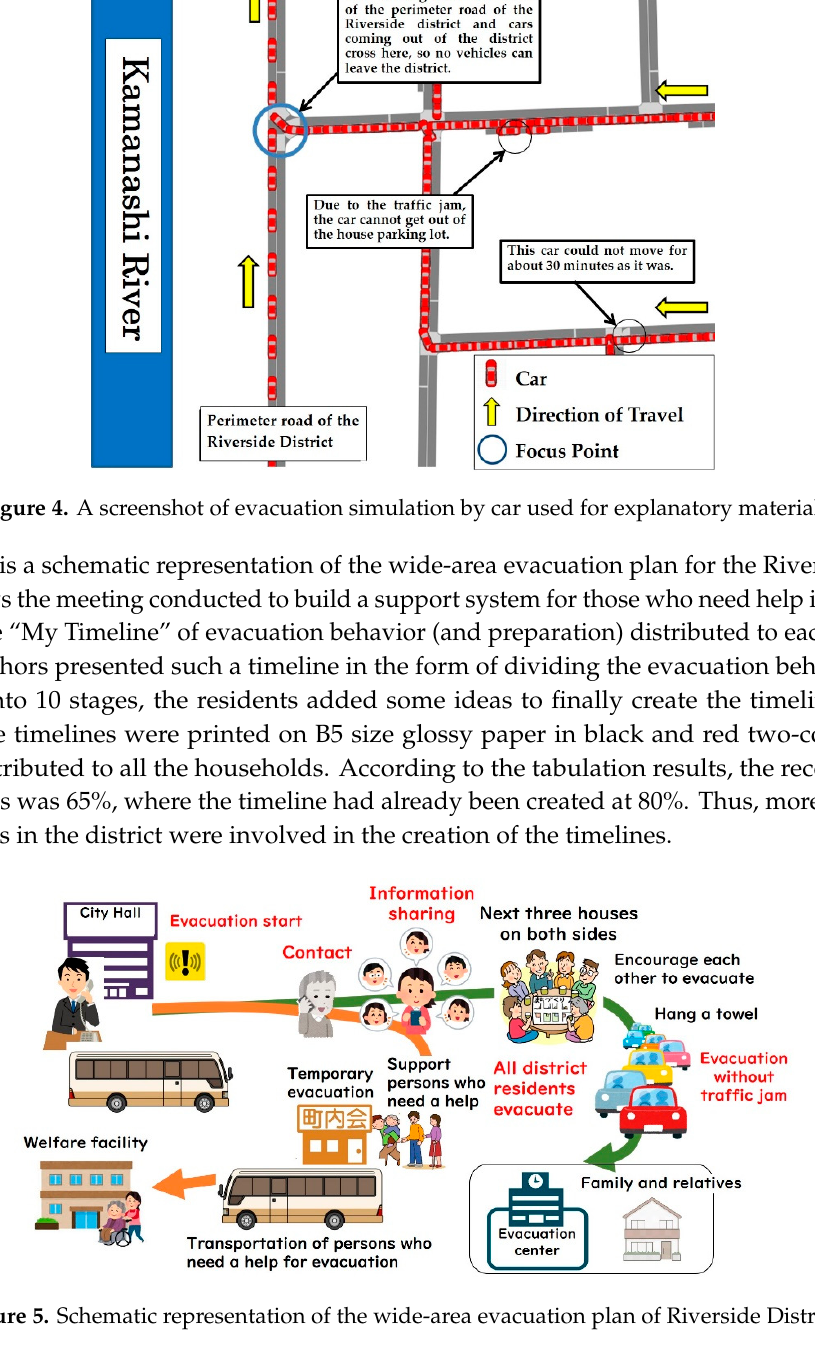
Figure 5. Schematic representation of the wide-area evacuation plan of Riverside District.